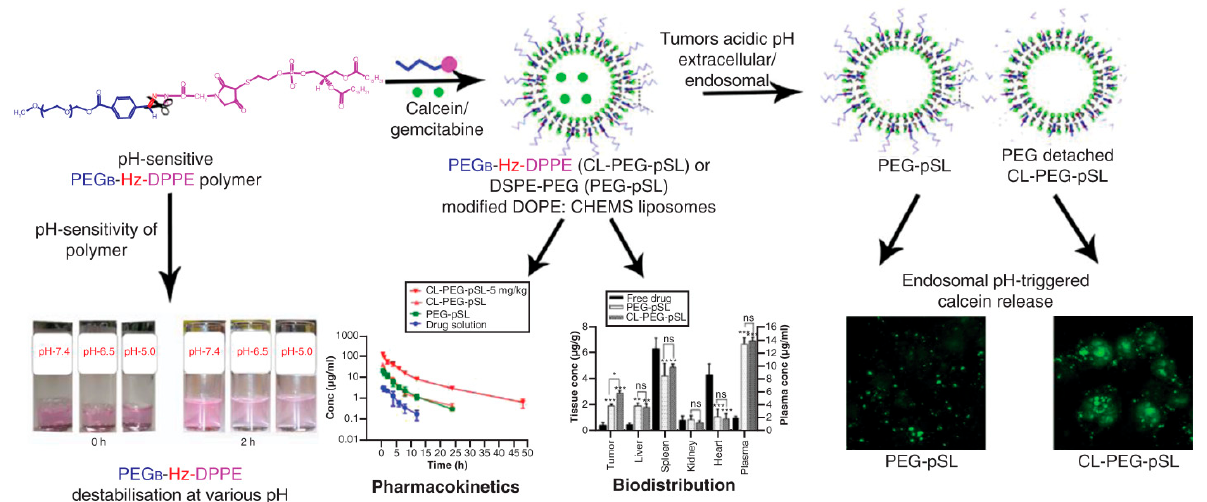
Figure 6. Liposomes modified with pH-sensitive PEG-Hz-DPPE polymers. DePEGylation was achieved by introducing a pH-sheddable hydrazide–hydrazone linker to the PEG–lipid conjugate. Under mild acidic environments, rapid endo/lysosomal escape and enhanced accumulation of drugs in model tumor cells show that cleavable PEGylation is an efficient strategy for cancer therapy. * p < 0.05; ** p < 0.01; *** p < 0.001 versus free drug. Adapted from Ref. [195]. Copyright © 2019, Future Medicine.